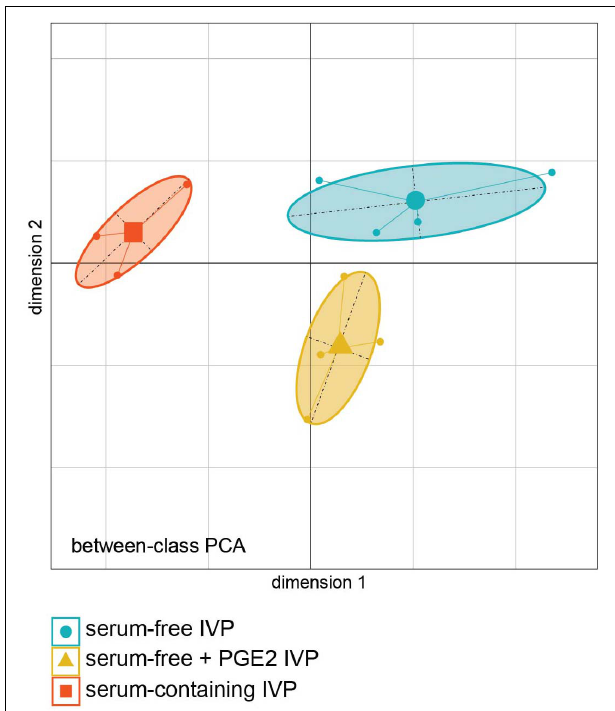
FIGURE 4 | Principal Component Analysis combined with duality diagram functions (dudi) was used to perform Between-Class Analysis with respect to ICM sample assignment to IVP treatment groups. ICM derived from day-7 grade-I blastocysts in vitro produced under “serum-containing,” “serum-free,” and “serum-free + PGE2” IVP conditions. Monte Carlo test based on 999 permutations demonstrates that groups are significantly different ( Monte Carlo P-value = 0.006). (PCA plot was generated using the Ade4 R package).